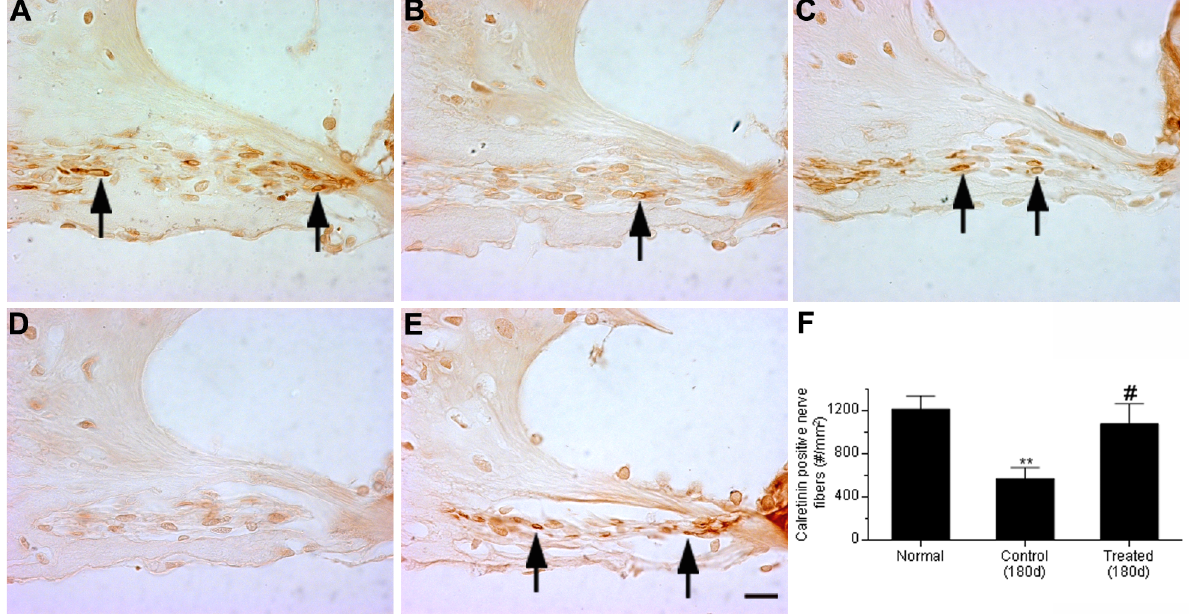
Fig 11. Calretinin staining in afferent nerve fibers in the middle turn spiral lamina of chinchilla. Representative images are shown from normal (na ï ve)animals(arrows in A), at 21 days after noise exposurein control (untreatedanimals)(B), at 21 days after noise exposure in HPN-07-treated animals(C), at 180 days after noise exposurein control animals(D) or at 180 days after noise exposure in HPN-07 treated animals(E). Fewer calretininpositive afferent nerve fibers were observed in the spiral lamina of chinchillaof noise exposure control groups (B and D). Density of calretininpositive afferent nerve fibers in the spiral laminaof chinchillawas measured in the middle and basal turns and statistically analyzed(F). Significantlydecreased densitiesof calretinin-positivenerve fibers were measuredin the spiral lamina at 6 months ( ** , p < 0.01) after noise exposurein the control group comparedto the HPN-07 treated group, which was similar to that of the normal (na ï ve)group. (#, p < 0.0 5 ). Scale bar = 10 μ m in E for A-E.